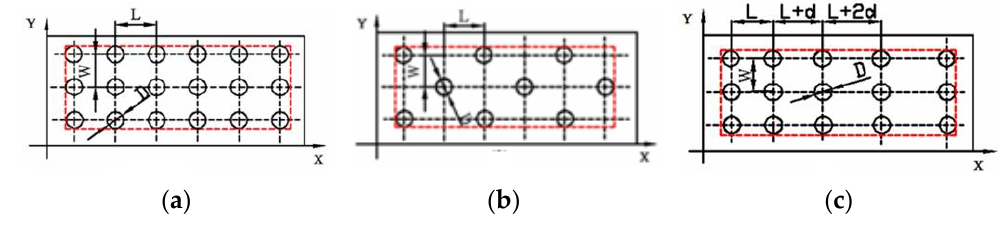
Figure 6. ( a ) Rectangle arrangement. ( b ) Rhombus arrangement. ( c ) Arithmetic arrangement.